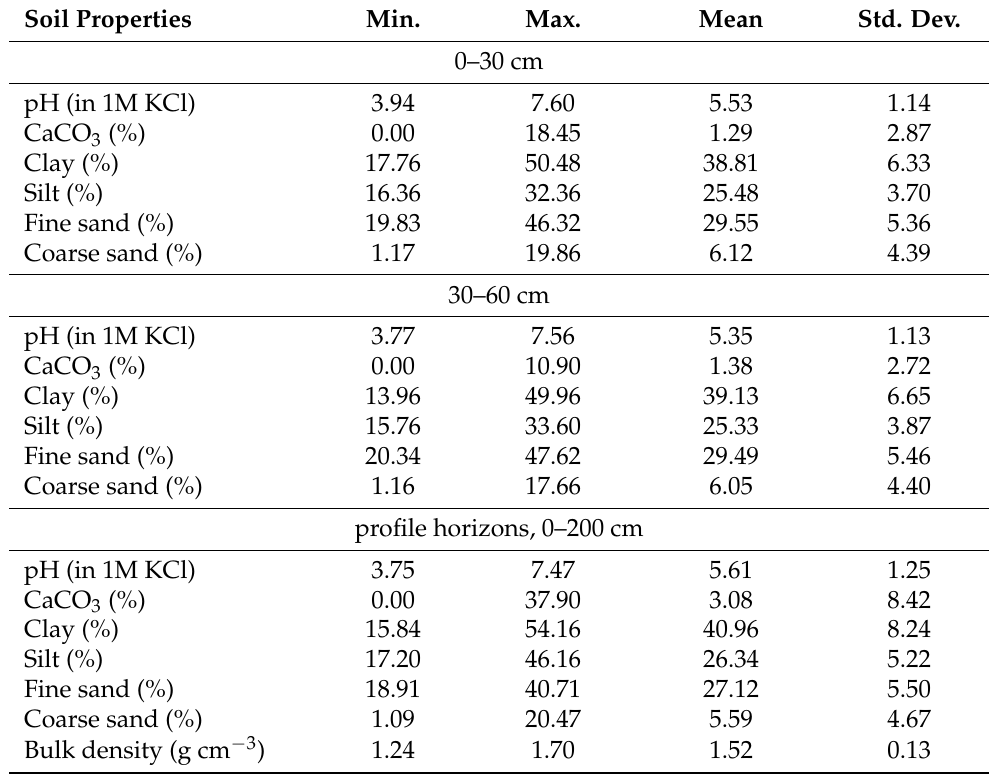
Table 3. Descriptive statistics of soil properties in layers 0–30, 30–60 cm and profile horizons (<200 cm). Soil Properties